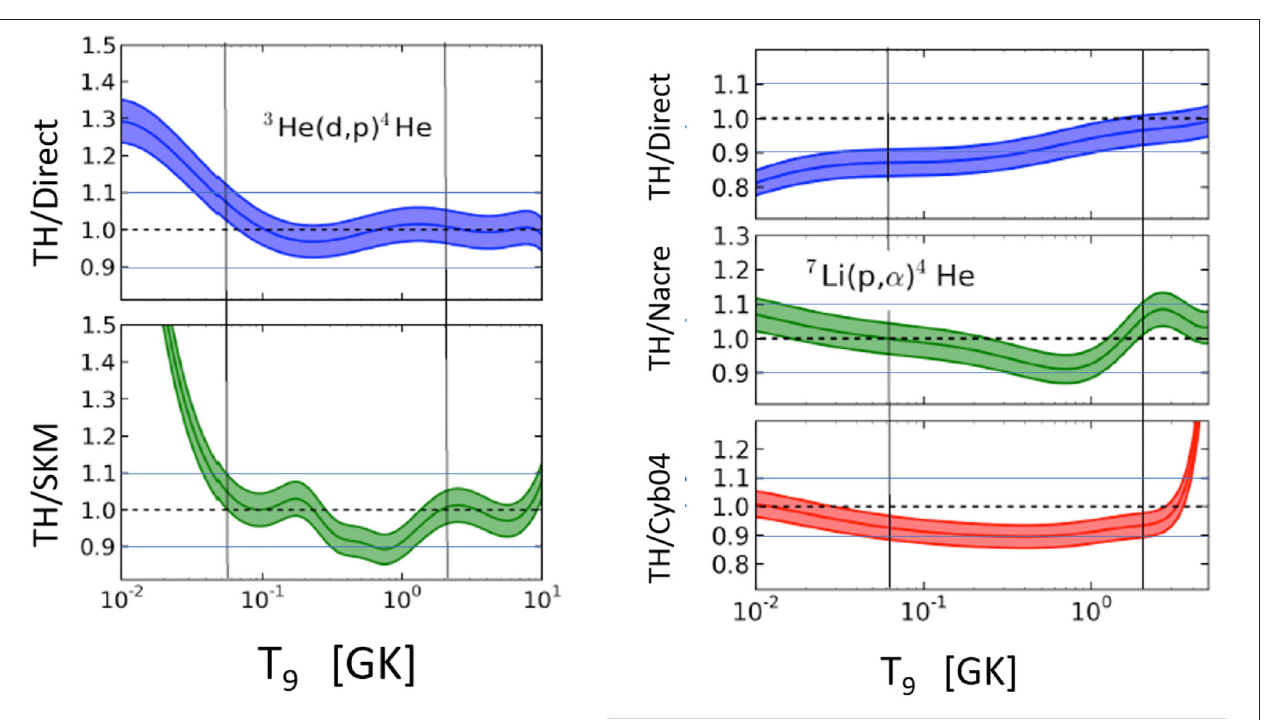
Frontiers in Astronomy and Space Sciences |